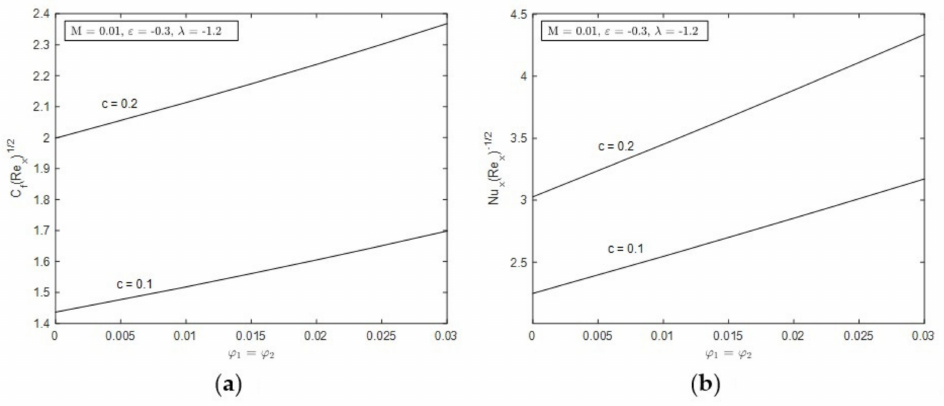
Figure 7. ( a ) Variation of C f with ϕ for different values of c . ( b ) Variation of Nu x with ϕ for different values of c .